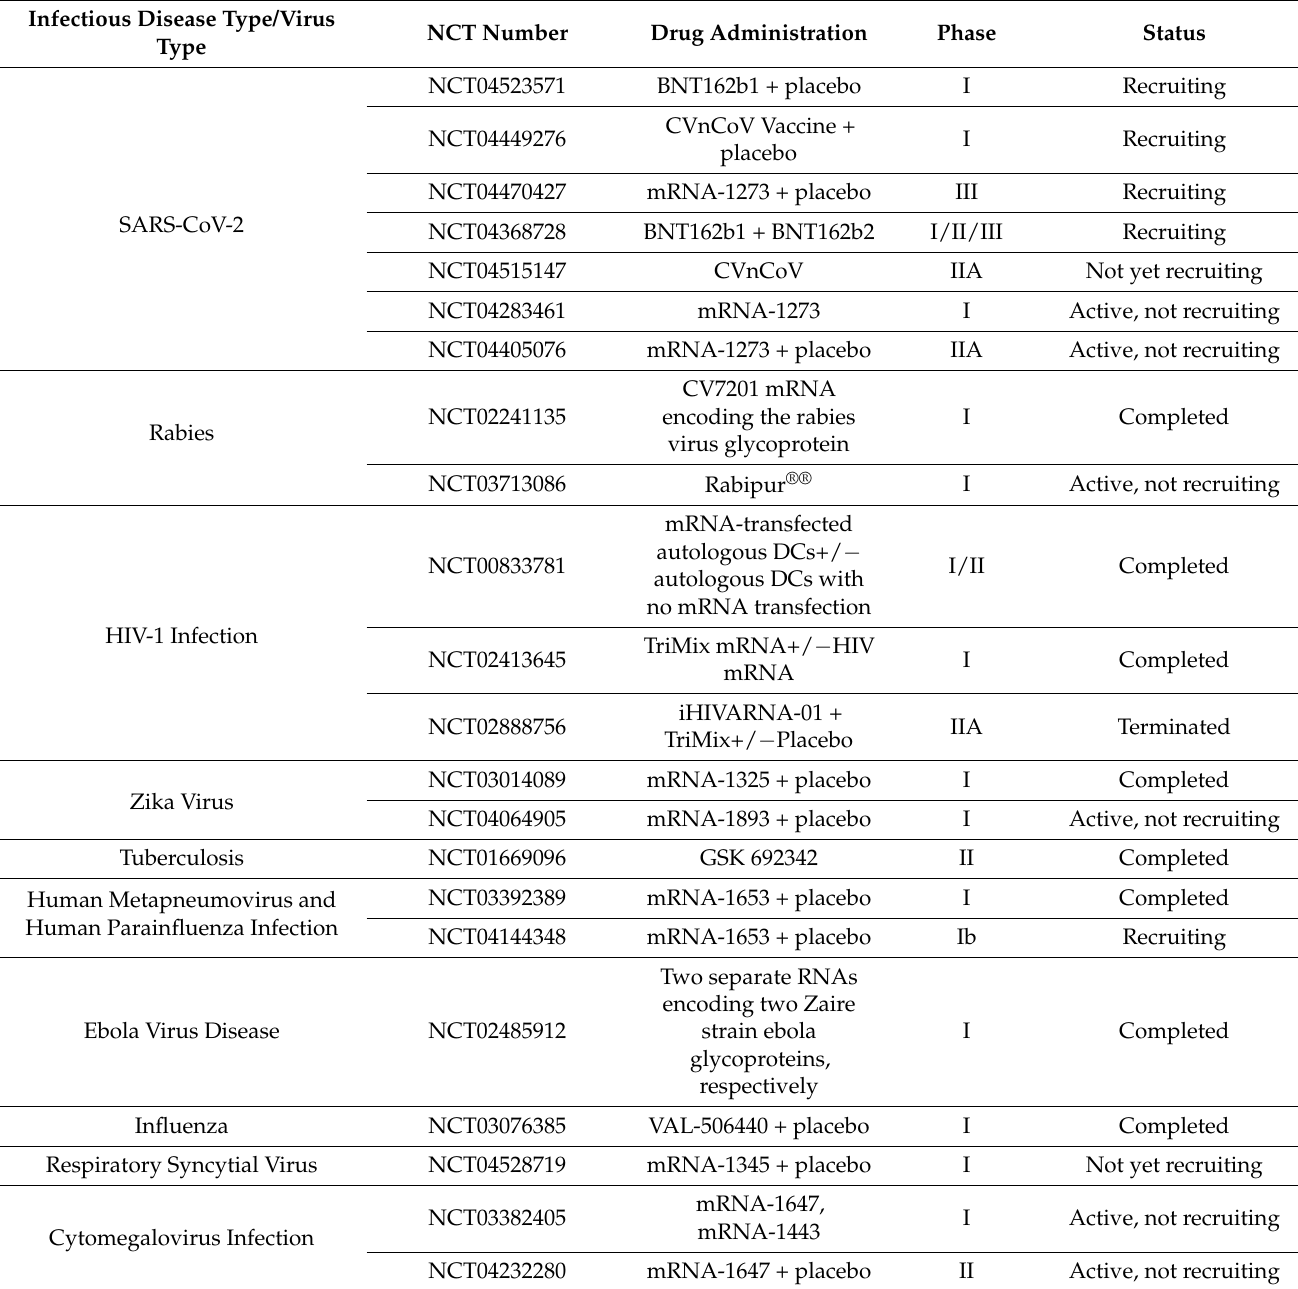
Table 4. Clinical trials with mRNA vaccines against viral diseases